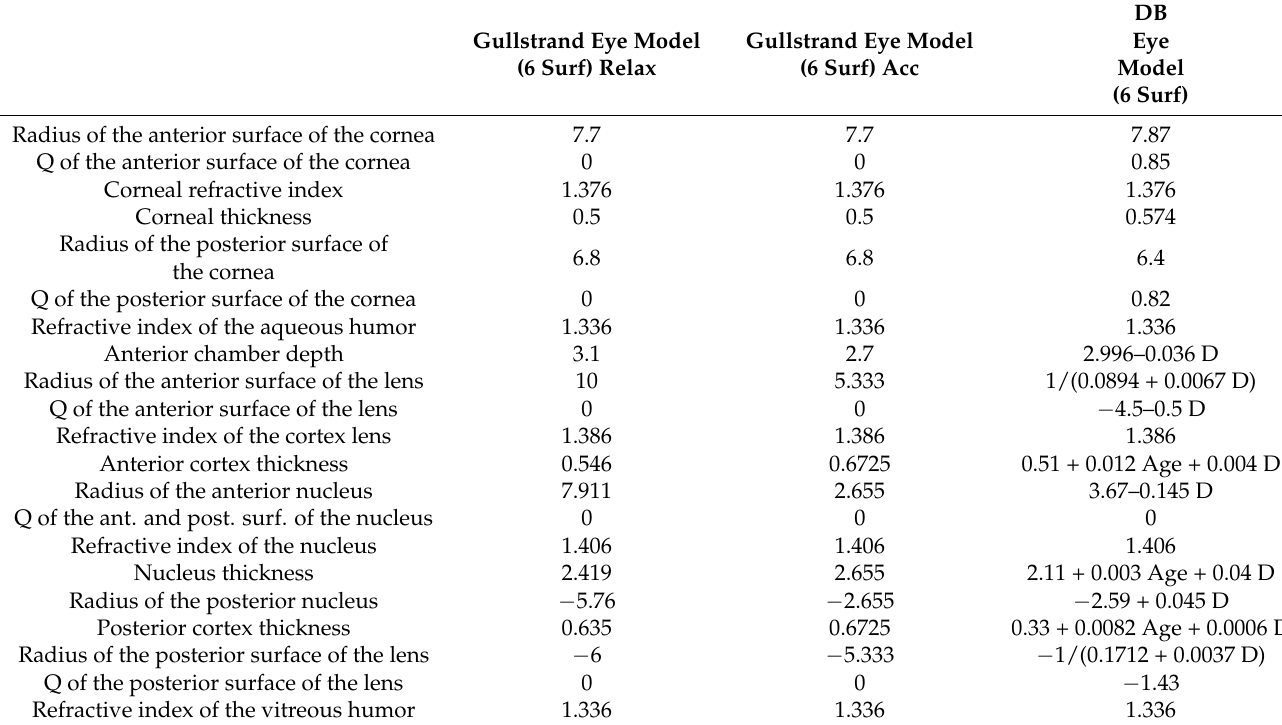
Table 1. Optical parameters of the original Gullstrand eye model, relaxed (2nd column) and ac- commodated to a stimulus at 10 cm from the eye (3rd column), and those corresponding to the DB eye model (4th column), where “D” represents the stimulus position in diopters (positive numbers indicate that accommodation is not relaxed), and “age” is measured in years. Distances are in